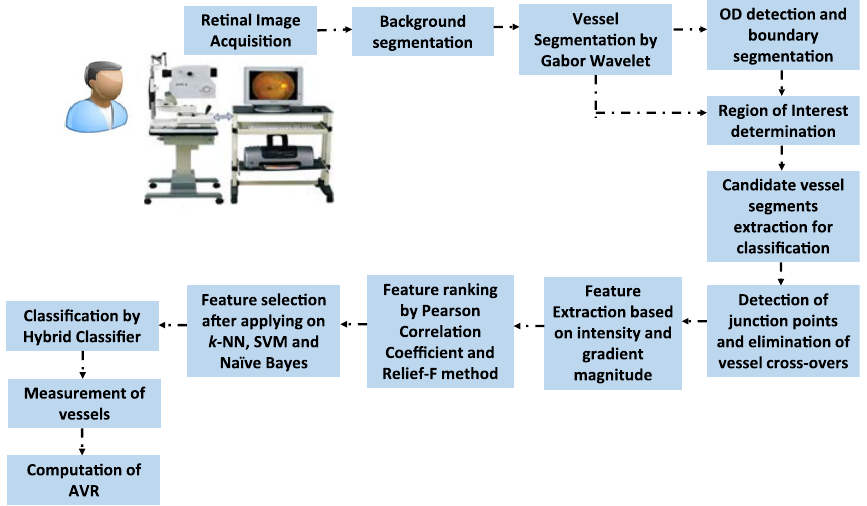
Fig. 3. Flow chart of proposed